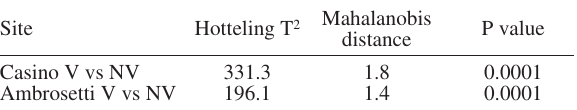
Table 1. – Differences between means for shell shape of the scorched mussel Perumytilus purpuratus sampled from vegetated (V) and non-vegetated (NV) patches in Casino and Ambrosetti rocky